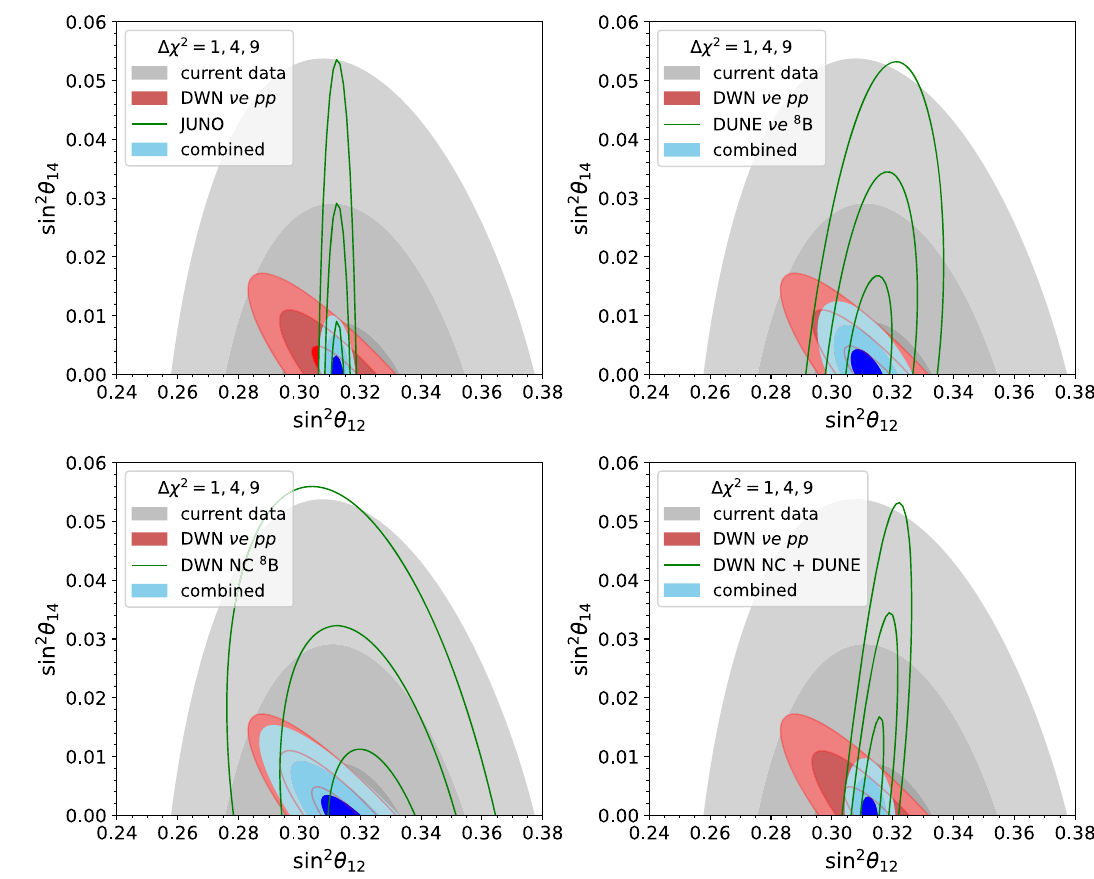
Fig. 6 Contours of (cid:4)χ 2 = 1 , 4 , 9 in the plane of sin 2 θ 12 and sin 2 θ 14 fordifferentcombinationsofcurrentdata(greyregion)withfuturemea- surements.Theredregioninallpanelscorrespondsto100tyexposureof DARWIN E ν ES data (natural 136 Xe abundance) combined with current